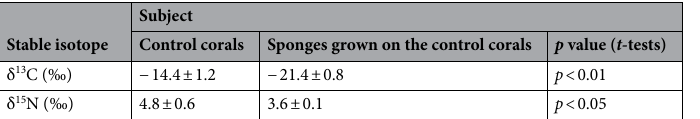
Table 2. The comparison of δ 13 C and δ 15 N between control corals and sponges grown on the control coral.